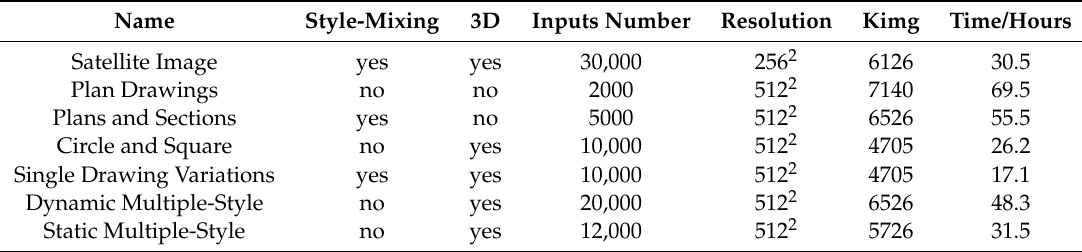
Table A1. This is the data sheet of each training process. ”Style-mixing“ refers to whether this training could make style-mixing or not. The ”3D“ refers to whether this training could generate clear serialized images to form a 3D model or not. The ”Inputs Number“ refers to how many images has been set into the training dataset. The ”Resolution“ refers to the resolution of the training images. The ”Kimg“ refers to the iterations of training process. The ”Time/hours“ refers to how many hours it will take for the single RTX 2080ti the author use to reach the purpose